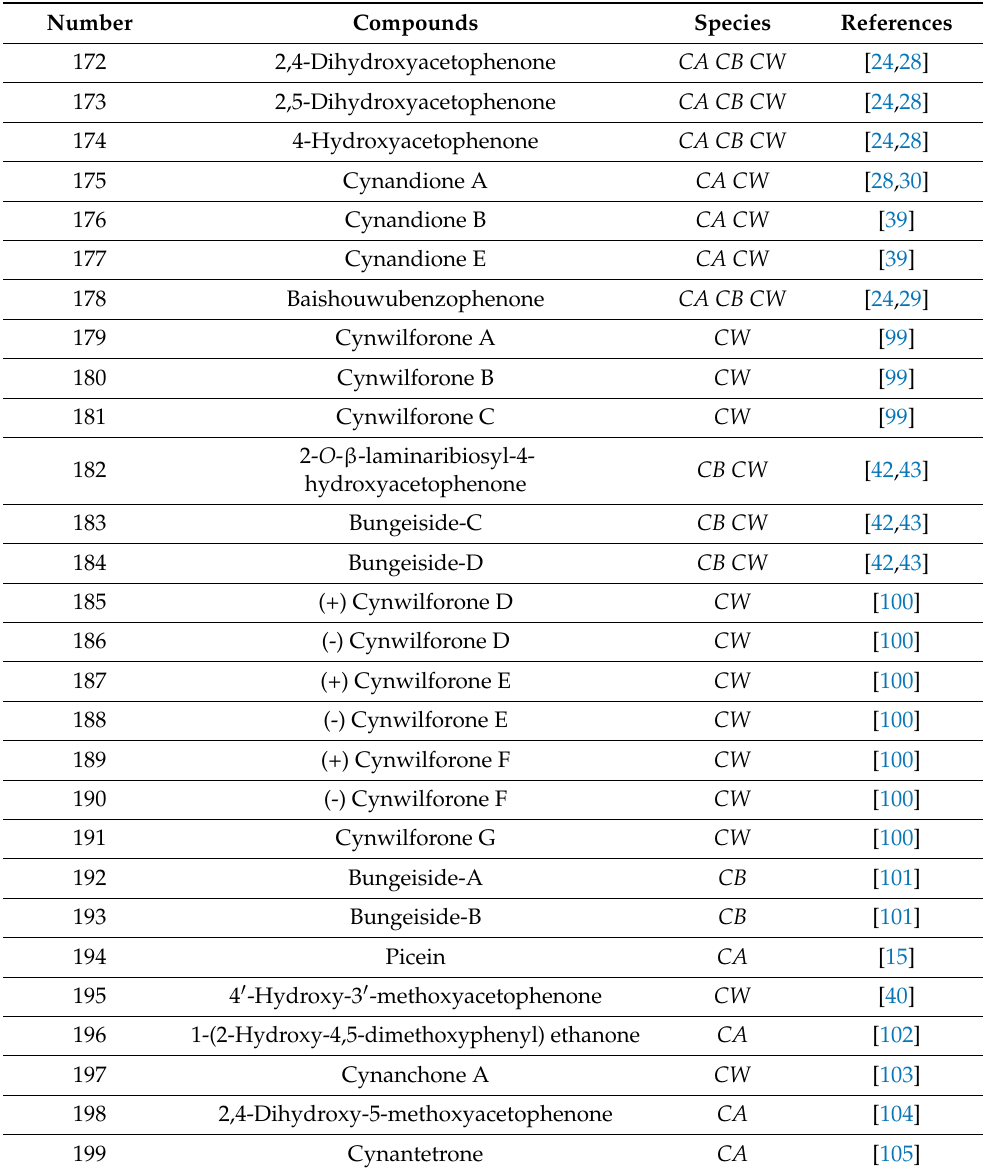
Table 2. Acetophenone compounds isolated from CA , CB and CW